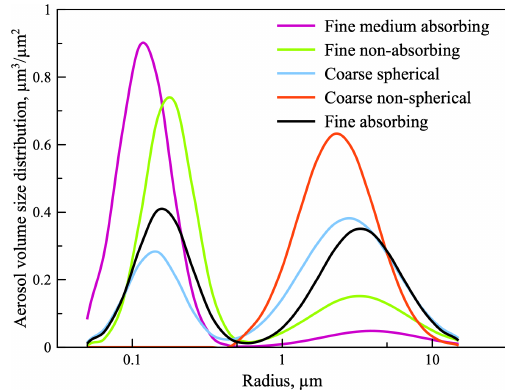
Figure 18. Normalized volume size distributions of different aerosol